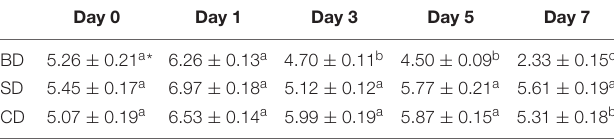
TABLE 2 | Total cultivable bacteria counts (TCBC) in PL shrimp (log CFU mg − 1 ).